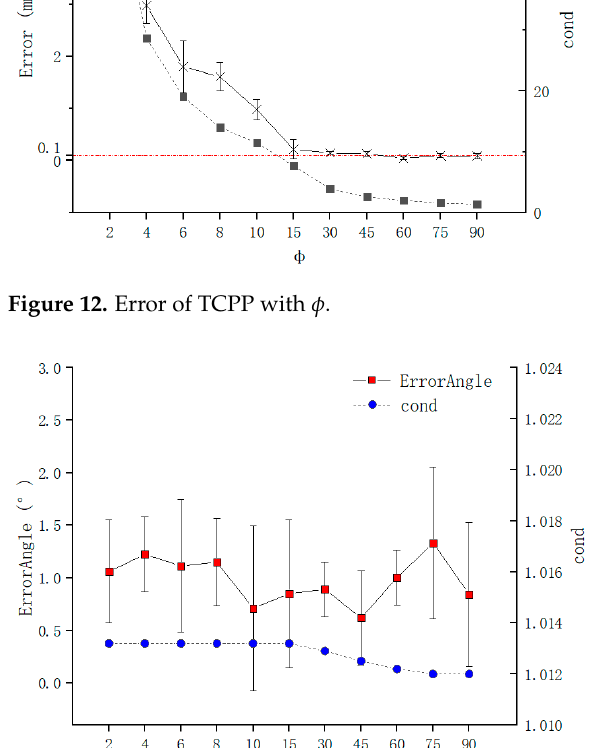
Figure 12. Error of TCPP with φ .